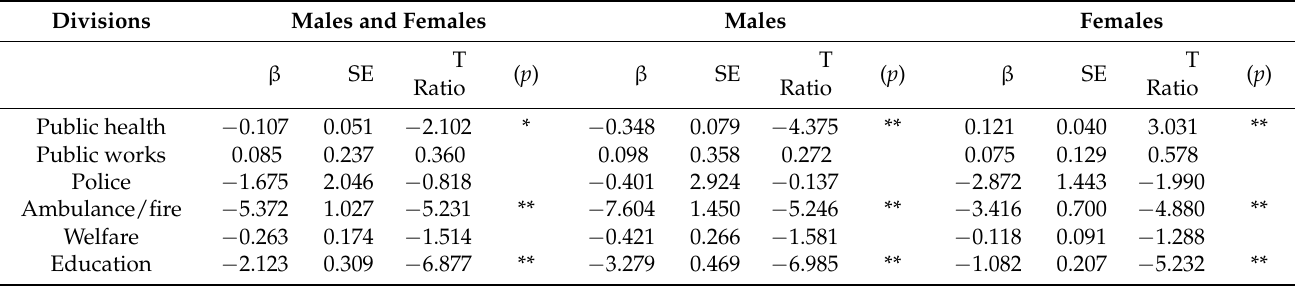
Table 2. Effects of financial expenditure per capita of six divisions of prefectures and municipalities on suicide mortality.